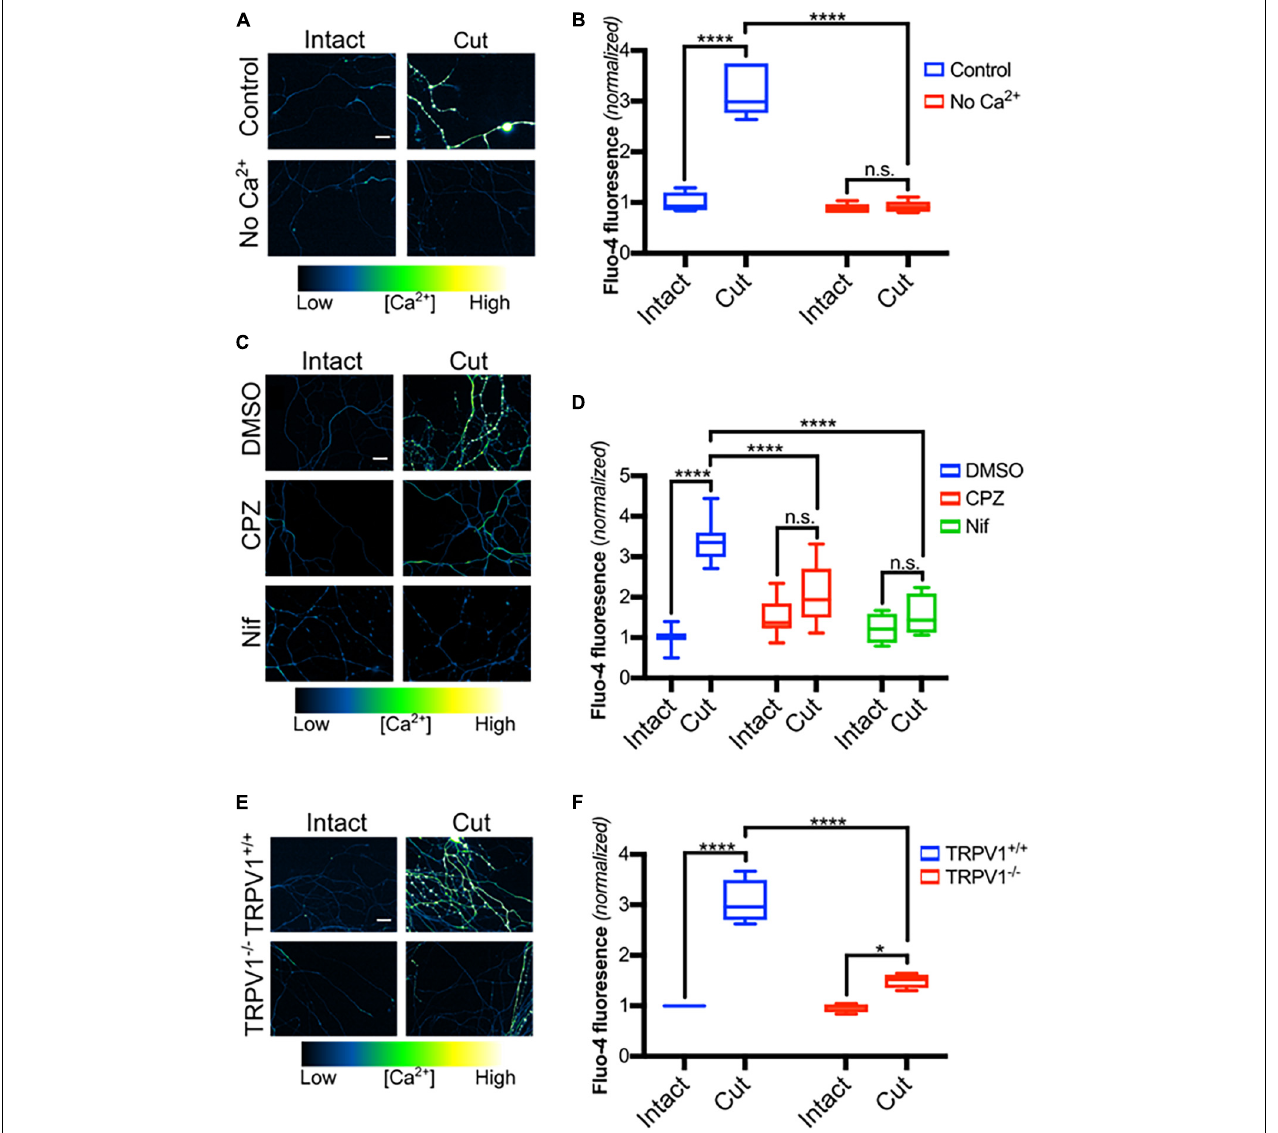
FIGURE 1 | TRPV1 inhibition reduces Ca 2 + influx in transected axons. (A) Micrographs of intact or cut DRG axons in the presence or absence of Ca 2 + (No Ca 2 + ), loaded with Fluo-4-AM (scale bar indicates 25 µ m) and imaged 3 h after axotomy. (B) Fluo-4 fluorescence intensity, normalized to fluorescence intensity of intact controls ( n = 6 for each group). Boxplots show minimum, 1st quartile, median, 3rd quartile, maximum. Statistical significance was assessed using a two-factor ANOVA followed by Tukey’s post hoc comparison. (C) Intact or cut axons in the presence or absence of CPZ (10 µ M – 30 min pre-incubation), nifedipine (Nif, 10 µ M -30 min pre-incubation) or DMSO (0.1% v/v- – 30 min pre-incubation), loaded with Fluo-4-AM (scale bar indicates 25 µ m) and imaged 3 h after axotomy. (D) Quantified Fluo-4 fluorescence intensity normalized to fluorescence intensity of intact DMSO controls [ n = 10 (DMSO), 8 (CPZ), 6 (Nif)]. Boxplots are